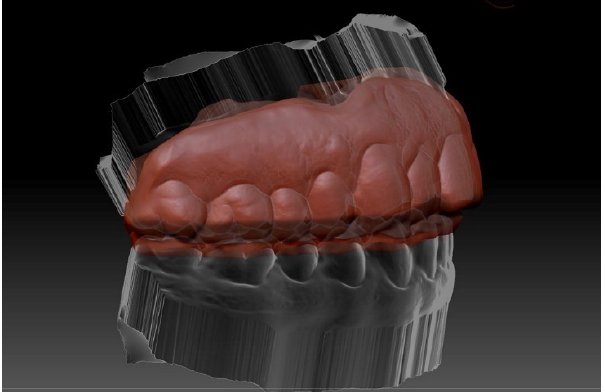
Figure 4. Design of the inner layer (red) (2 mm) using “inflat” tool in the Zbrush software.